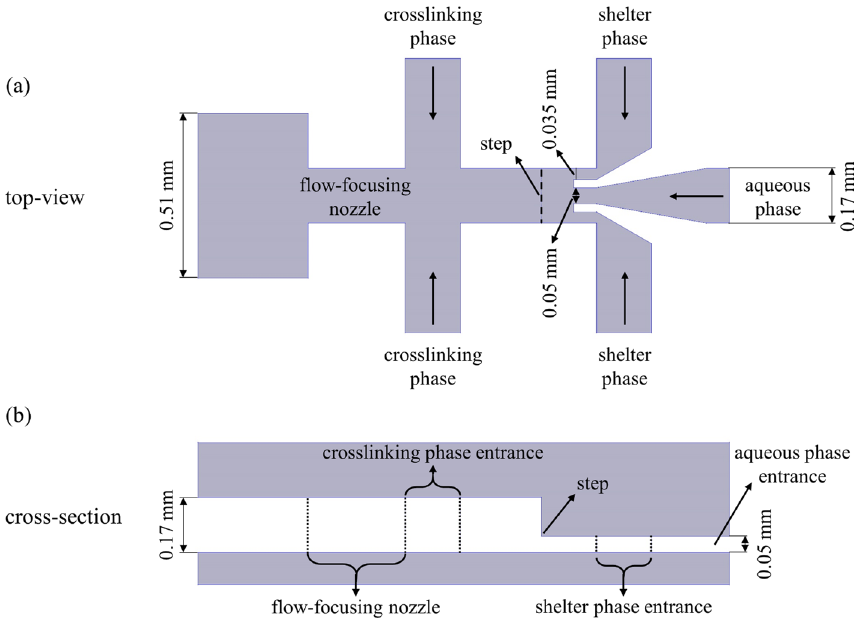
Figure 1. Schematic illustration of the designed microfluidic system. ( a ) top-view. ( b )